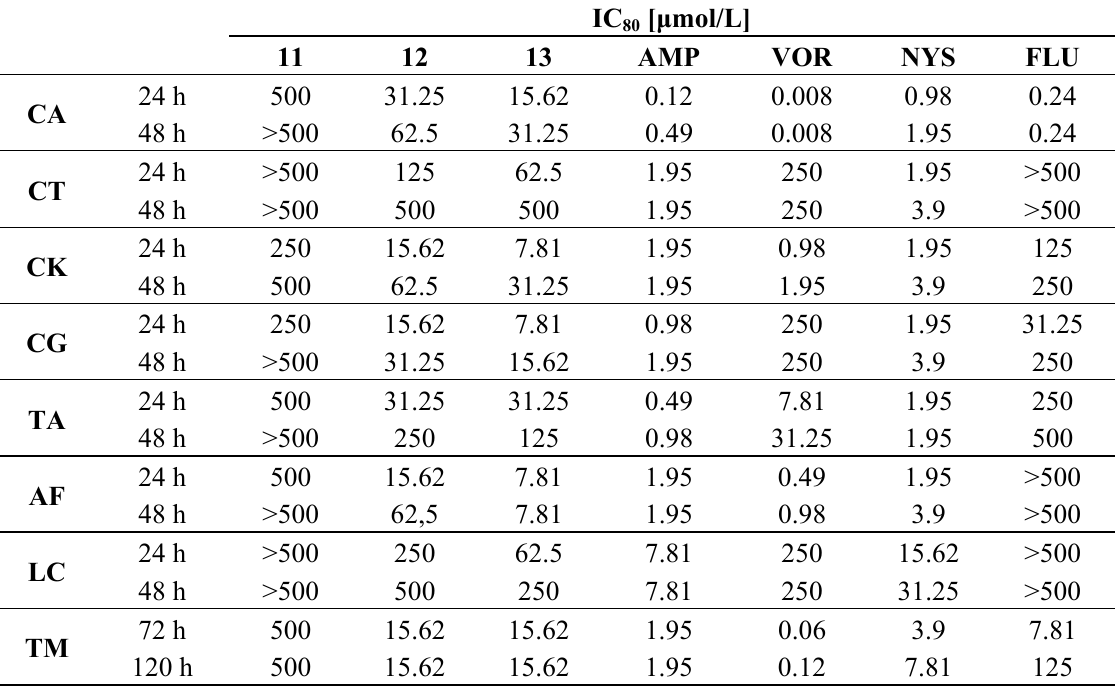
Table 3. Results of antifungal evaluation for the compounds with alicyclic side chains and corresponding